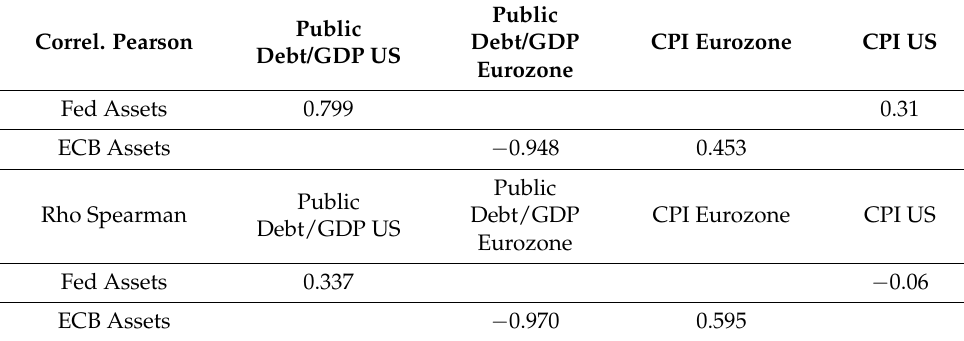
Table 3. Correlation of balance sheet expansion with public debt and CPI. Public Public Debt/GDP CPI Eurozone CPI US Correl. Pearson Debt/GDP US Eurozone Fed Assets 0.799 0.31 ECB Assets − 0.948 0.453 Public Public Debt/GDP CPI Eurozone CPI US Rho Spearman Debt/GDP US Eurozone Fed Assets 0.337